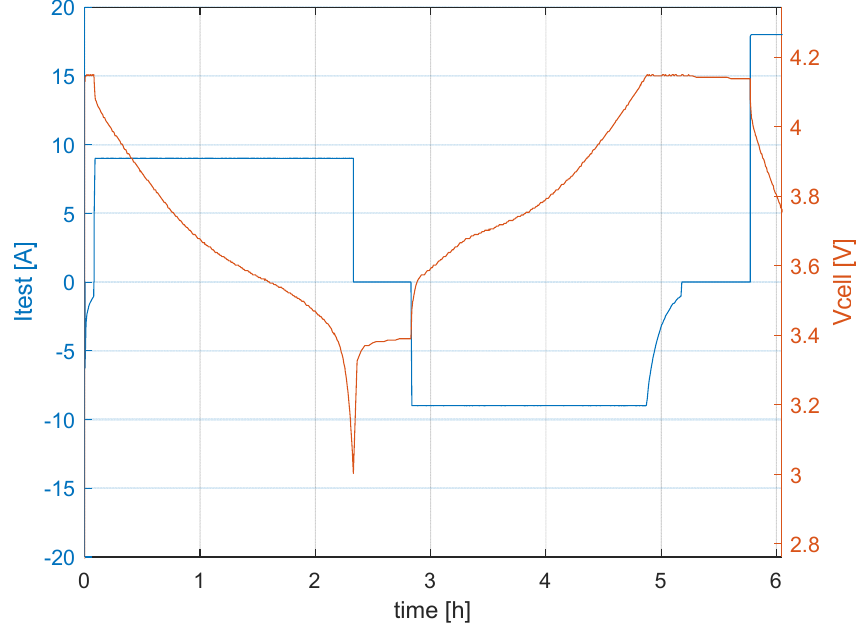
Figure 2. Typical discharge–charge profile for EiG PLB C020 cells.